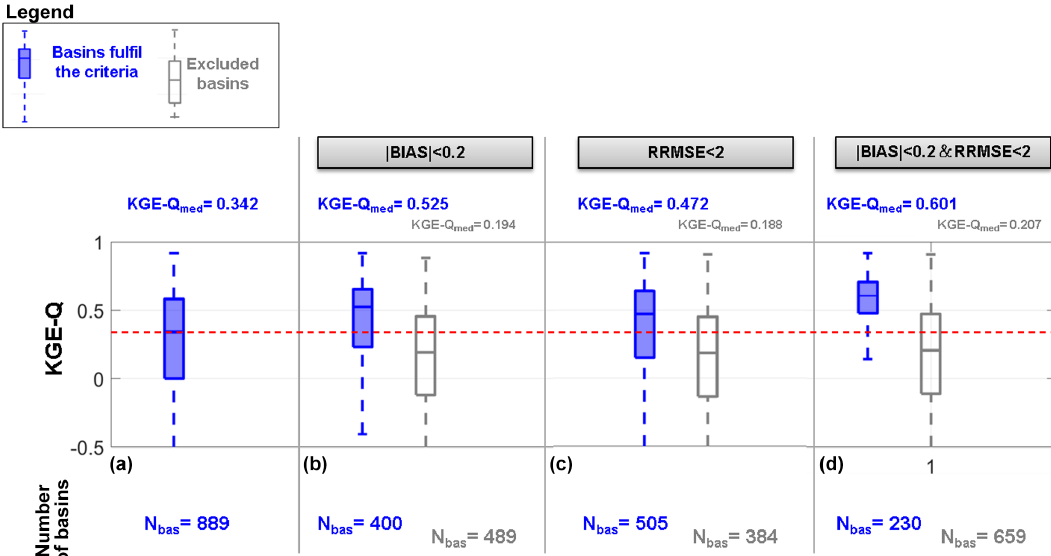
Figure 5. Hydrological performances in terms of the KGE values obtained during the validation period by the three satellite rainfall products for all the basins whose outlet section is located over the TMPA area (889). The following hydrological performances are shown: (a) without any constraint on the rainfall scores, (b) constraining the module of rBIAS to values lower than 0.2, (c) constraining RRMSE to values lower than 2 and (d) constraining the module of rBIAS to values lower than 0.2 and RRMSE to values lower than